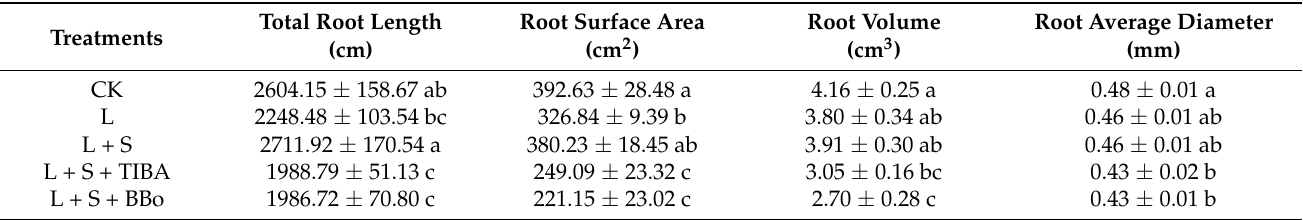
Table 3. Effects of exogenous sucrose and IAA inhibitors on root morphology of M. baccata under sub-low